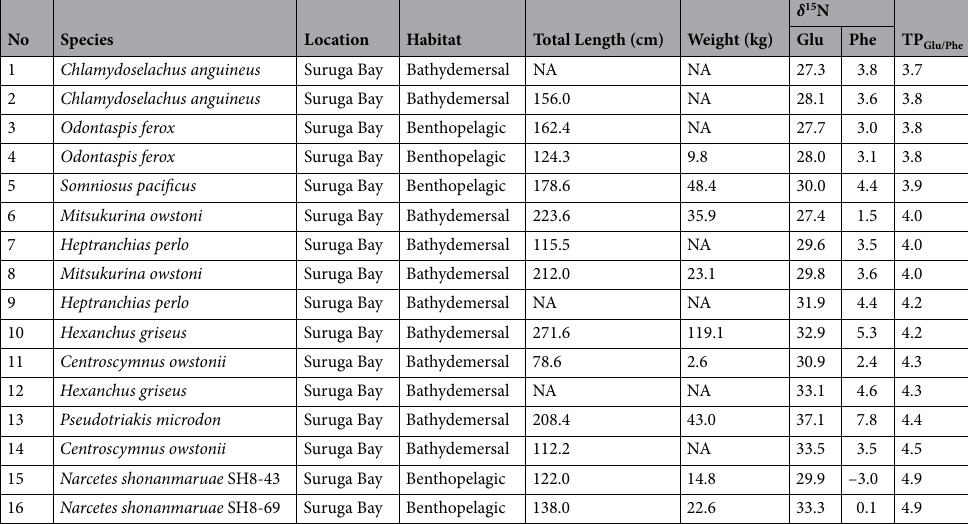
Table 3. The trophic position of fishes examined in this study. Positions were calculated using the nitrogen isotopic compositions of glutamic acid and phenylalanine using the following equation: TP Glu/Phe = (δ 15 N Glu – δ 15 N Phe – 3.4)/7.6 + 1.